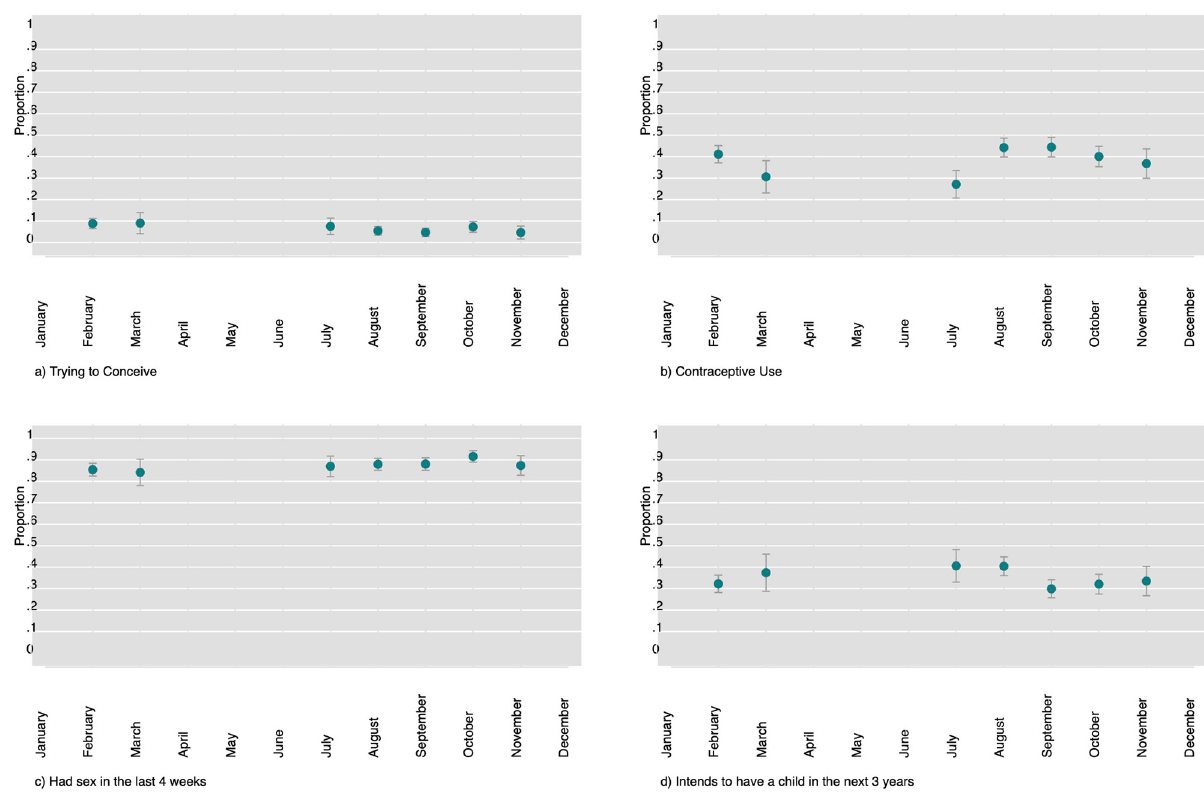
Fig 3. Proportion of 18-49 year old’s that are currently trying to conceive, using modern contraceptive methods, that have had sex in the last four weeks and that have fertility intentions in the next 3 years.